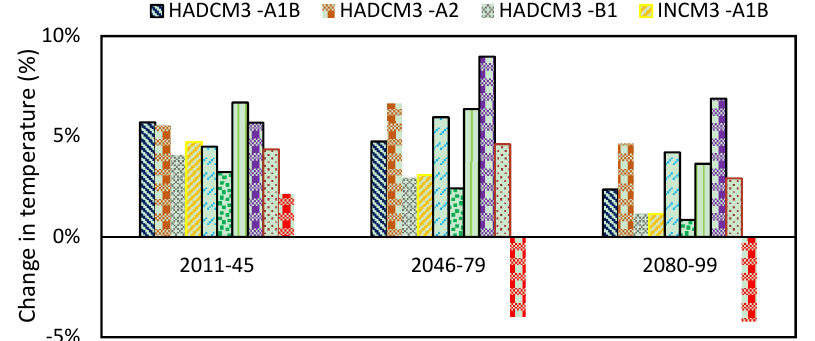
Figure 11. Mean temperature change predicted by the various models.